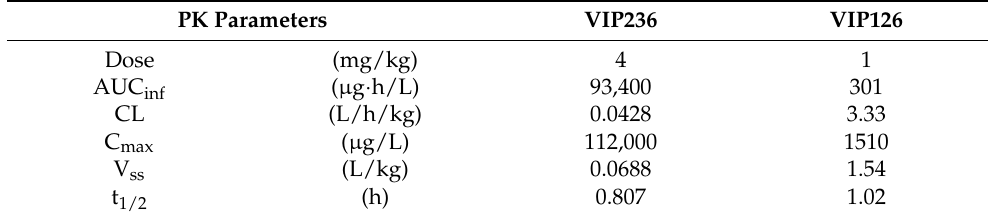
Figure 3. The higher tumor-to-plasma ratio of VIP126 after VIP236 administration results in marked anti-tumor efficacy in vivo. Concentration of VIP236 and VIP126 in tumor and plasma following the administration of ( A , B ) the VIP236 conjugate or ( C ) the VIP126 payload directly. 786-O tumor-bearing mice ( n = 2 mice/group at each timepoint) were treated i.v. with a single dose of VIP236 (4 mg/kg) or VIP126 (1 mg/kg, via tail vein). The doses of VIP236 and VIP126 were chosen so that an equimolar amount of VIP126 was administered regardless of whether it was delivered utilizing VIP236 or delivered directly. ( D ) Growth curves of 786-O tumors in female NMRI nu/nu mice ( n = 8/group) treated with vehicle or VIP236 (36 mg/kg, 3on/4off, i.v.). Statistical analyses were performed using Table 4. Pharmacokinetics of VIP236 and VIP126 in female NMRI nu/nu 786-O tumor-bearing mice following administration of a single i.v. dose of VIP236 (4 mg/kg) or VIP126 (1 mg/kg). The doses of VIP236 and VIP126 deliver equimolar amounts of VIP126. Pharmacokinetic parameters were estimated from mouse concentration–time profiles ( n = 2 mice/timepoint).